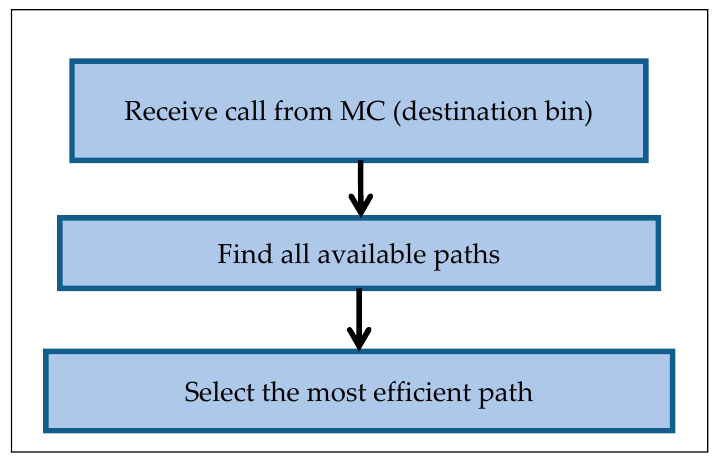
Figure 8. Process of the transportation system.